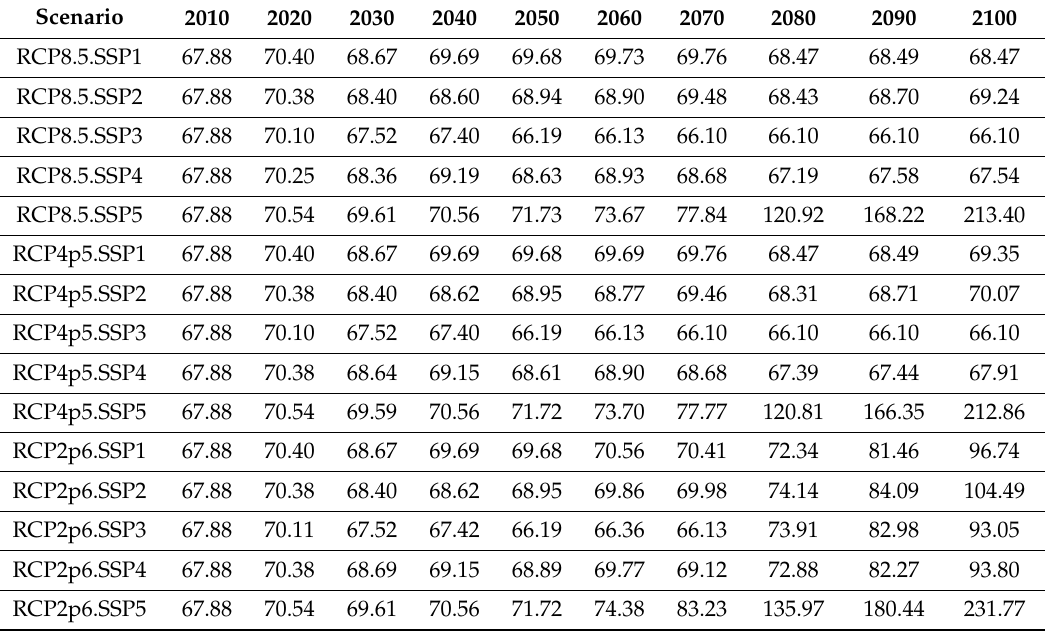
Table A12. Prices—Sawlogs (National average price per m 3 , in USD (exchange rate in 2010)). Scenario